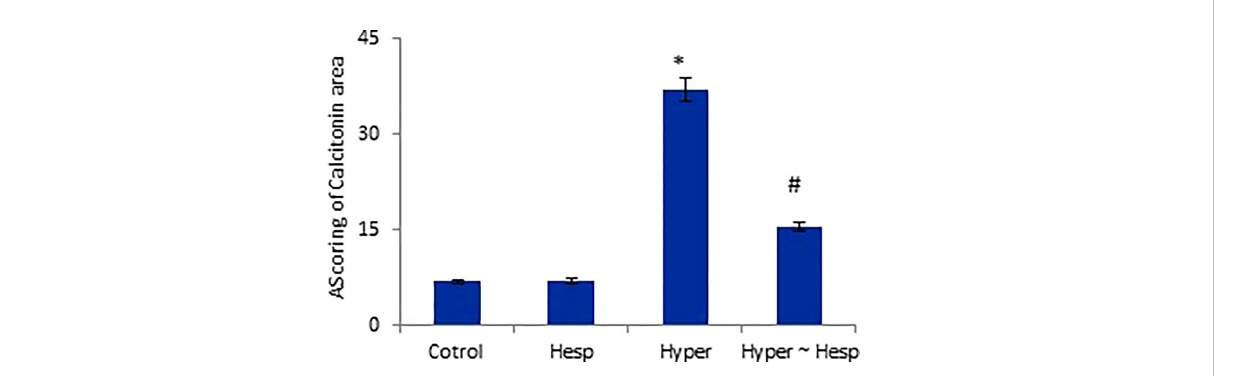
FIGURE 5 Scoring of Calcitonin area of healthy and hyperthyroidism treated animals ’ groups as compared to control group. Data are presented as mean ± standard error, and they were subjected to one-way ANOVA followed by post-hoc test (Duncan) at p ≤ 0.05. Symbol * is signi fi cantly different from control group, while symbol # is signi fi cantly different from hyperthyroidism